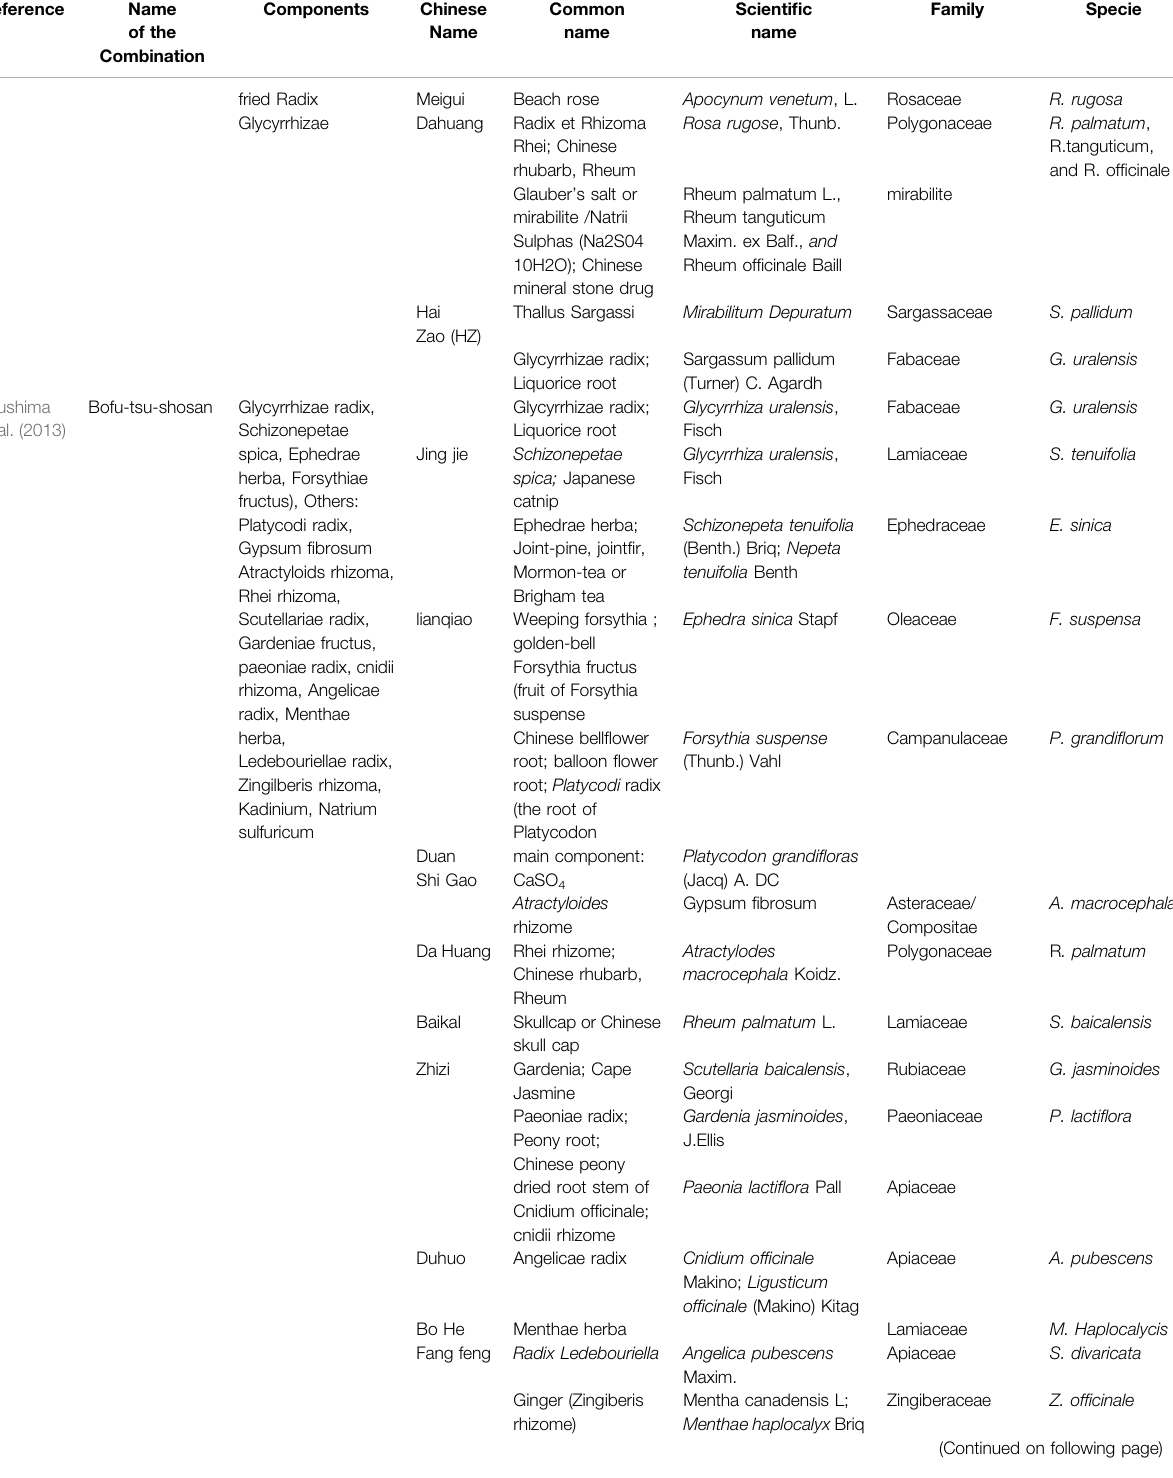
TABLE 1 | ( Continued ) Taxonomic classi fi cation of all the polyherbal combinations reviewed in animal